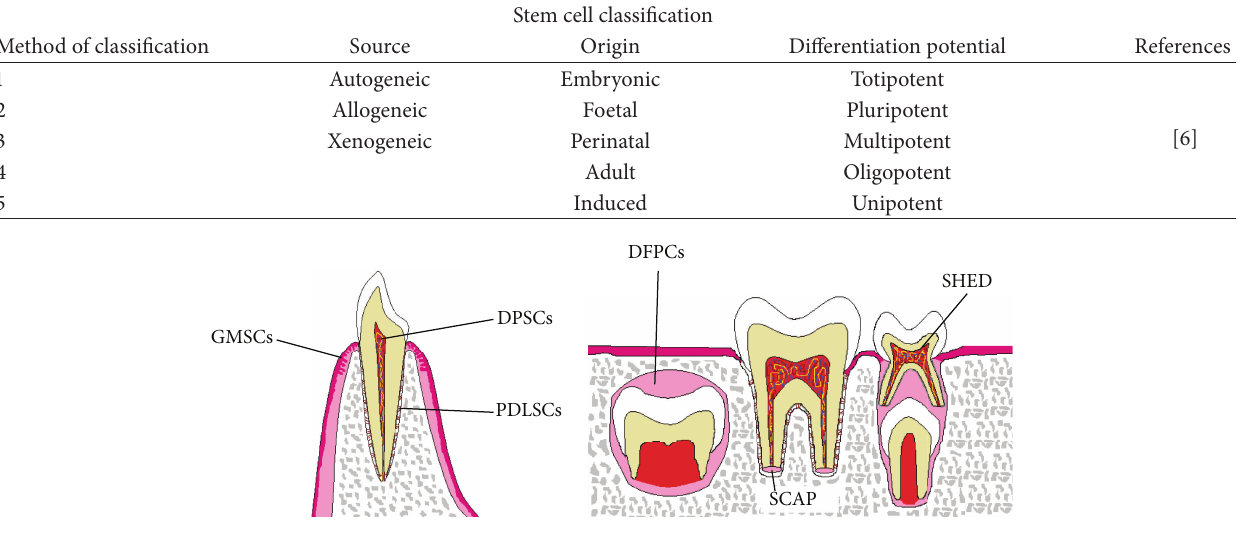
Figure 1: Illustrated are the separate origins of dental stem